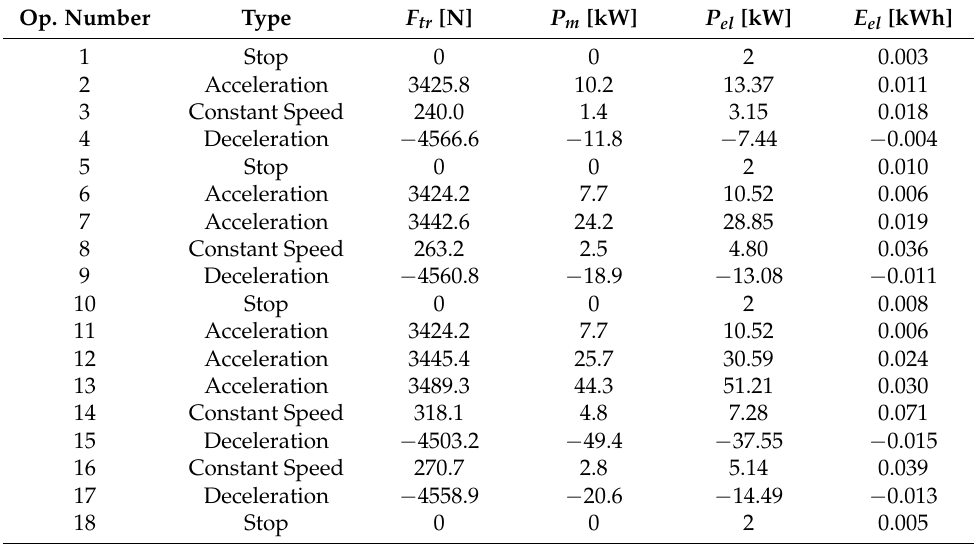
Table 7. Energy quantities of the chosen elementary urban cycle. Op. Number